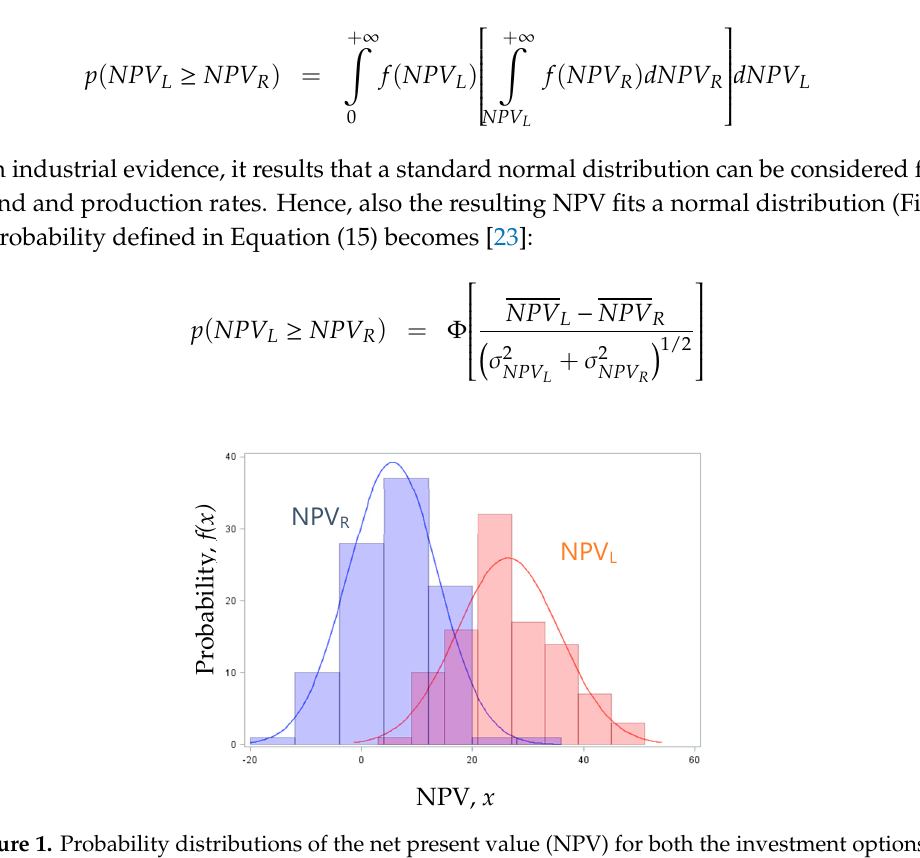
Figure 1. Probability distributions of the net present value (NPV) for both the investment options.